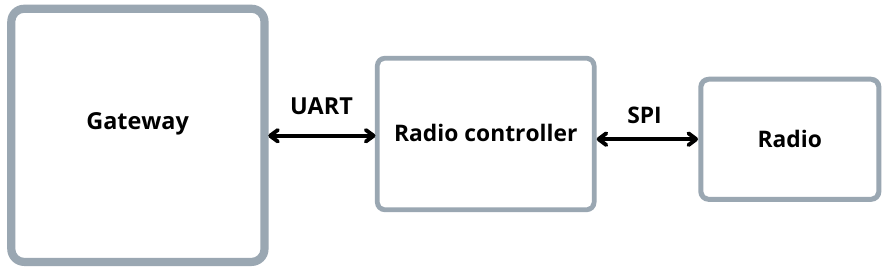
Figure 3. The block diagram for the gateway part of the system. No direct connection between the gateway and the radio was possible, so an intermediary device was necessary, to act as a radio controller. For the gateway, we used a Raspberry Pi 3B+; for the radio controller, we used an Arduino Uno; and an RFM69HCW for the